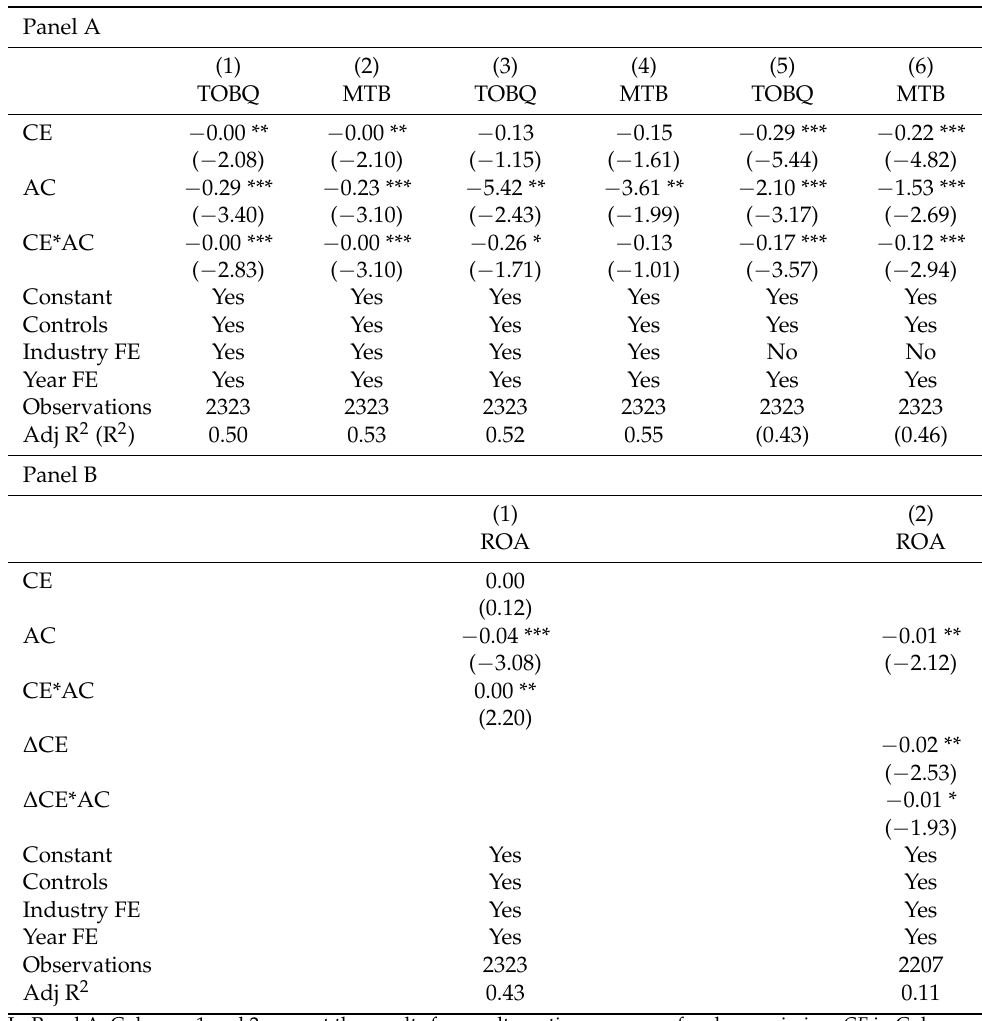
Table 5. Robustness tests. Panel A, alternative measure for carbon emissions and agency costs; Panel B, alternative measure for firm